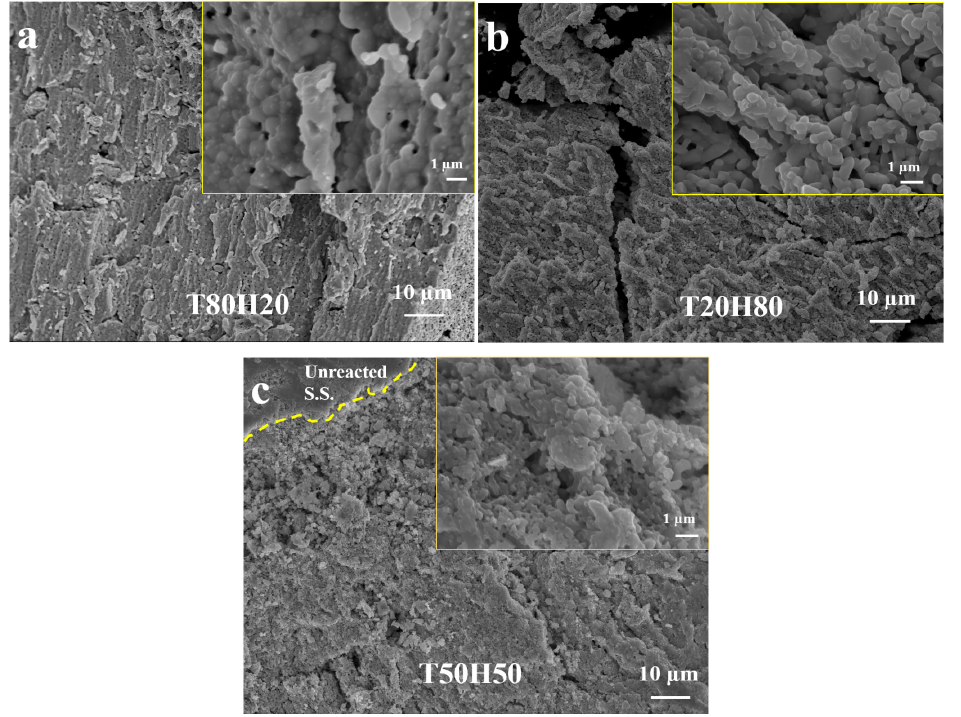
Figure 5. Post-oxidation SEM images of ( a ) T80H20 (inset showing the top view of the elongated grains); ( b ) T20H80; and ( c ) T50H50. (Insets are high magnification images).